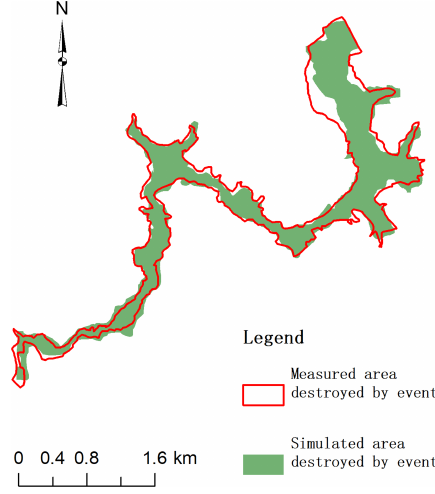
Figure 12. Comparison of simulation results and measurement re- sults in the area destroyed by the Feijão